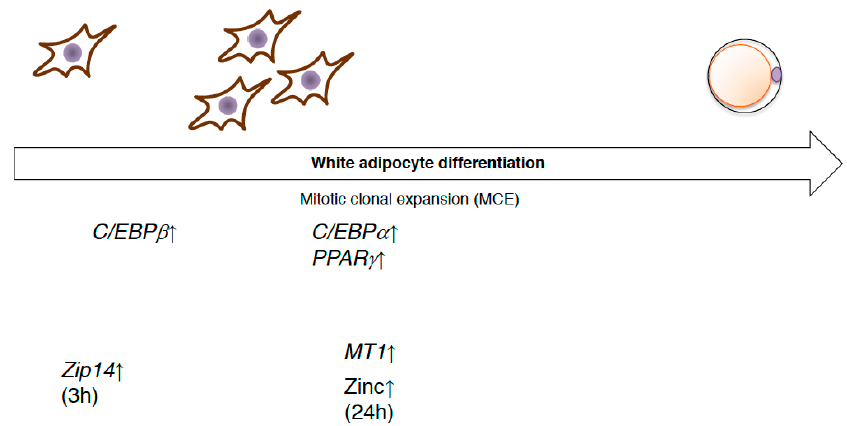
Figure 4. The expression of zinc transporters during white adipocyte differentiation. Preadipocytes are differentiated and trigger DNA replication and reentry into the cell cycle (mitotic clonal expansion, MCE). The expression of several genes related to zinc homeostasis is altered.